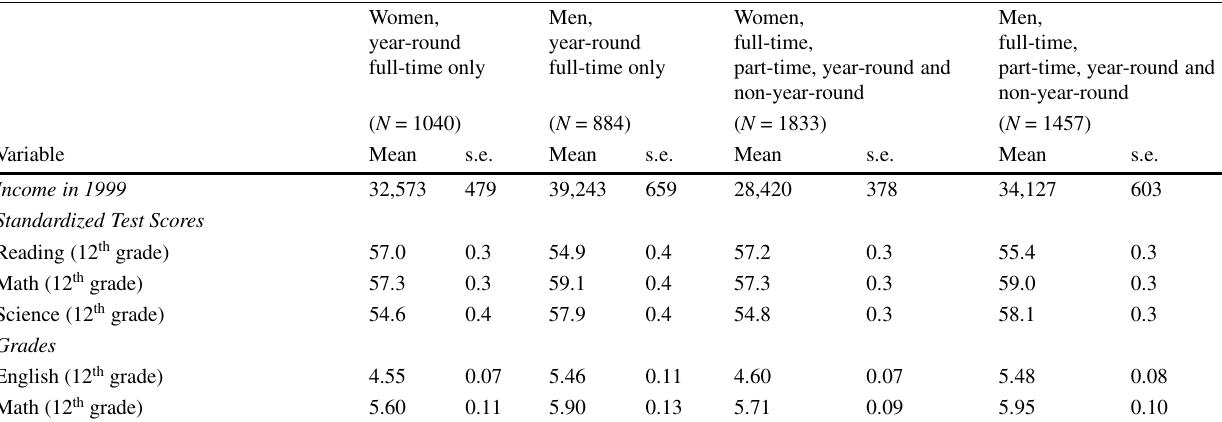
Table 3 Descriptive statistics by gender and sample